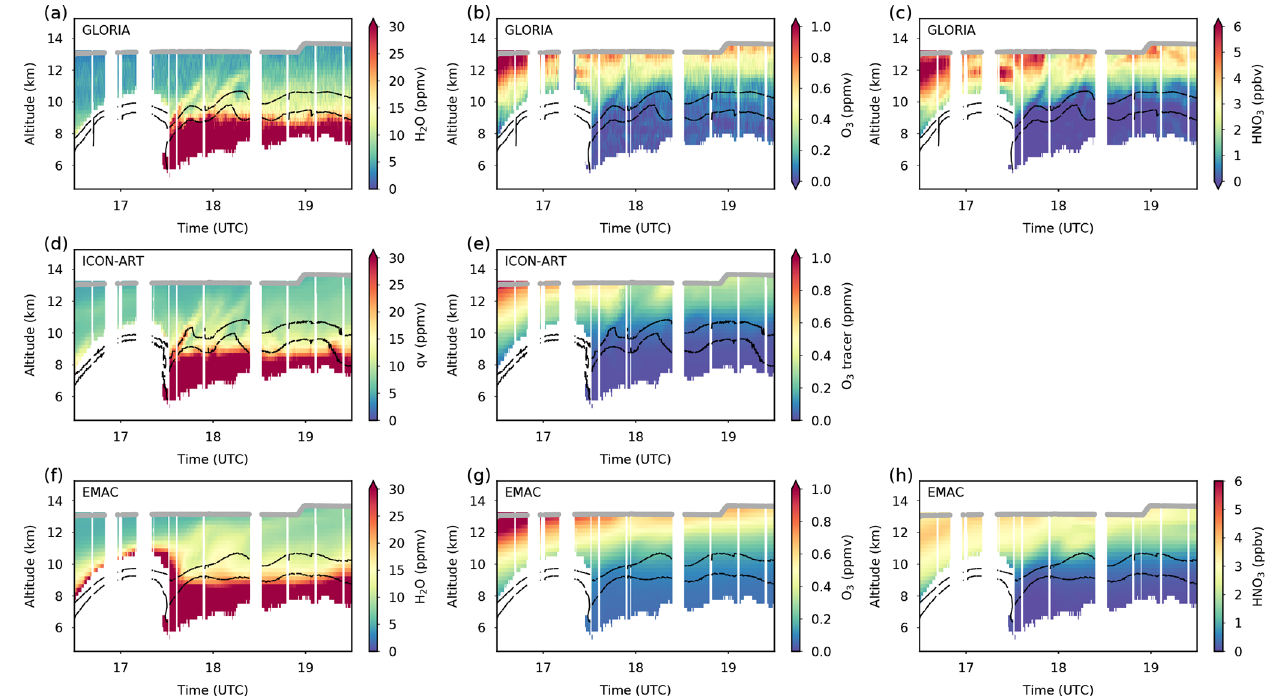
Figure 9. Close-ups of troposphere-to-stratosphere exchange region between 17:30 and 19:30UTC. In the case of ICON-ART, the nested data are shown. For legend, see Fig.